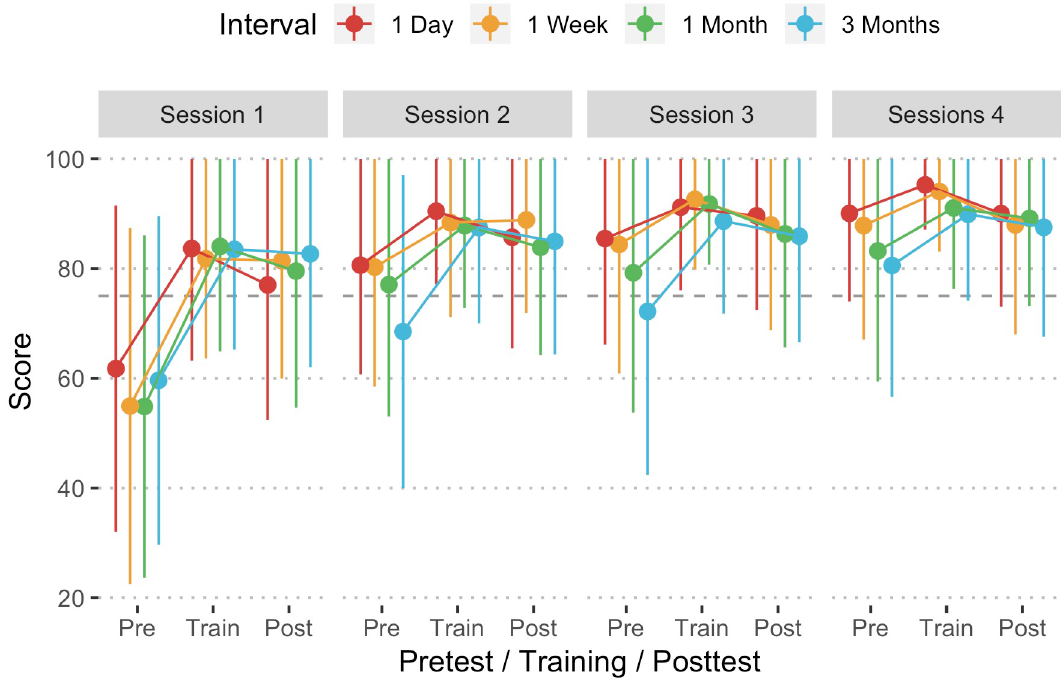
Fig 2. Mean overall compression score (1 SD Error Bar) by interval, pretest/training/posttest assessment, and session. Horizontal dashed line at 75 represents the minimum performance